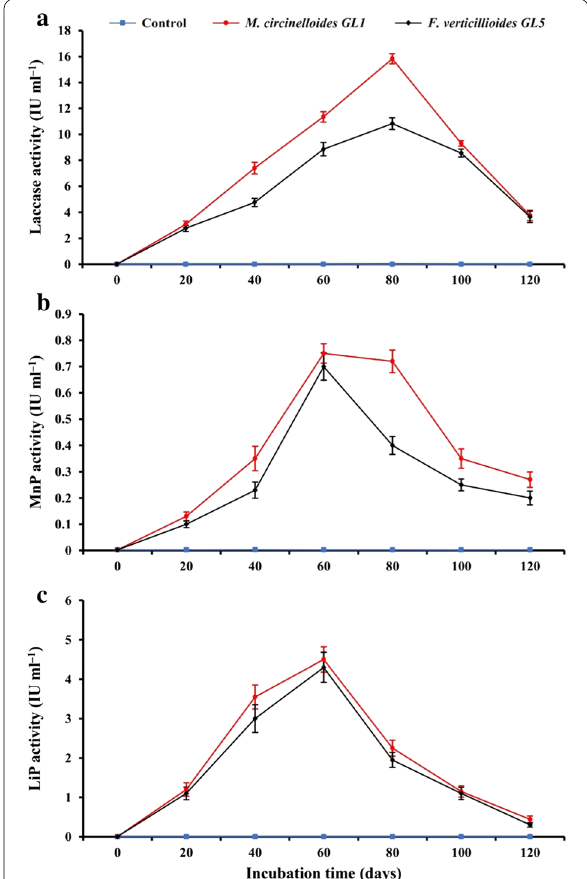
Fig. 4 Changes in CMCase enzyme activity of different solid substrates treated with ligninolytic fungi during solid-state fermentation in different time intervals. a areca husk, b coffee husk and c paddy